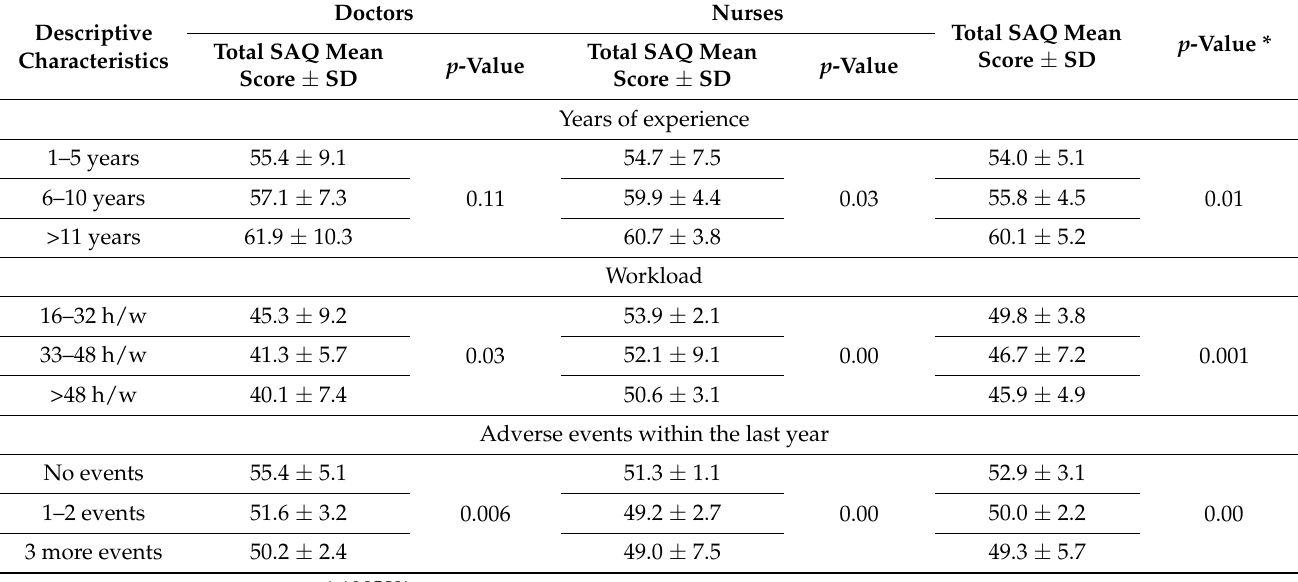
Table 4. Comparison of the Participants’ Patient Safety Attitudes perceptions with Workload, Adverse events, and